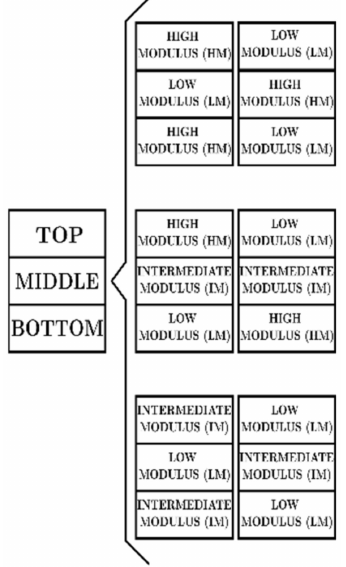
Figure 5. Layered lattice structures